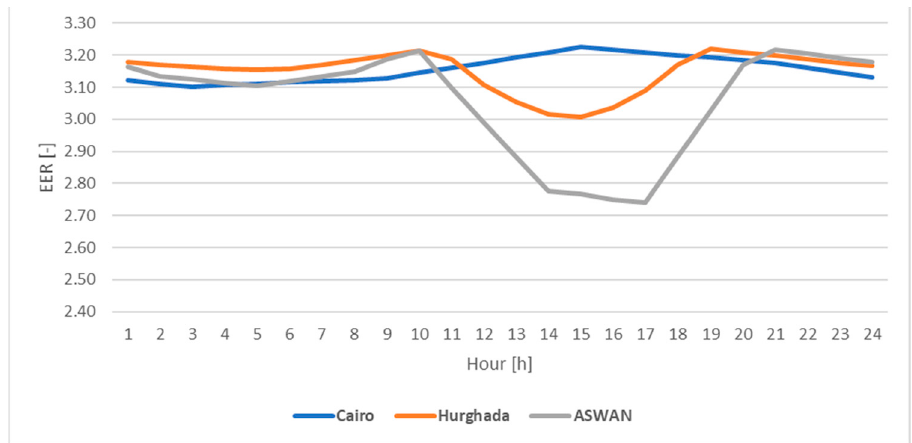
Figure 5. Energy efficiency ratio (EER) variation throughout the 21st of August in the three cities.